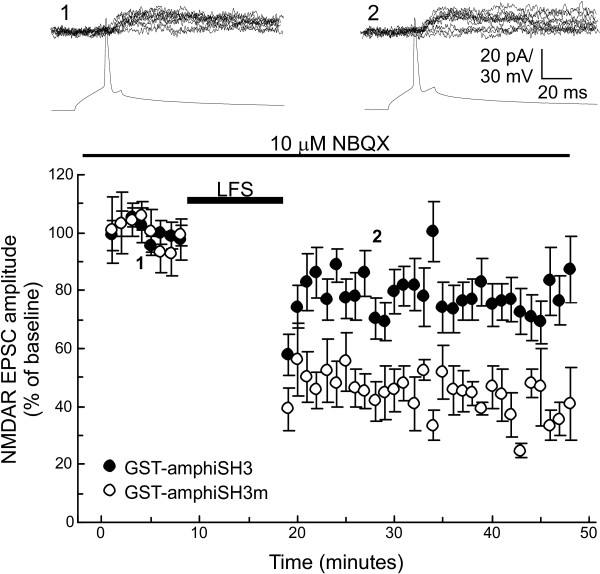
Prevention of dynamin-dependent endocytosis of NMDARs by injection of GST-amphiSH3 (100 μg/ml) into the postsynaptic cell significantly attenuates LFS-induced NMDAR down-regulation. The fusion protein was present in the postsynaptic internal solution for the duration of the experiment. Following the attainment of an active synaptic connection (characterized by the appearance of an AMPAR-mediated current at resting membrane potentials), NMDAR-mediated EPSCs were isolated by bath application of NBQX (10 μM) and depolarization to +40 mV. Baseline NMDAR EPSC amplitudes were measured for 10 minutes and then the synaptic pair was subjected to LFS (600 presynaptic action potentials at 1 Hz combined with slight postsynaptic depolarization; [6]). NMDAR EPSC amplitudes were subsequently measured for 30 minutes following LFS. Inset shows ten consecutive postsynaptic traces collected at +40 mV in NBQX, with an exemplar presynaptic action potential, before (1) and 10 minutes after (2) LFS. Closed symbols: GST-amphiSH3 (n = 10 pairs), open symbols: GST-amphiSH3m (n = 6 pairs) protein.